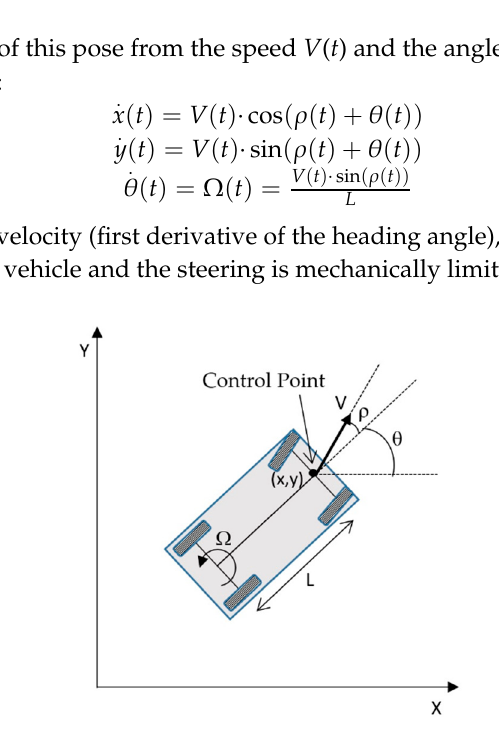
Figure 3. Kinematic model of an automobile with Ackerman steering. The control point is the central point of the front wheel’s axle. The kinematic model obtains the evolution of the location of the control point ( x, y, θ ) as a function of the speed V ( t ) and the angle ρ ( t ) of a virtual central front wheel at the control point.